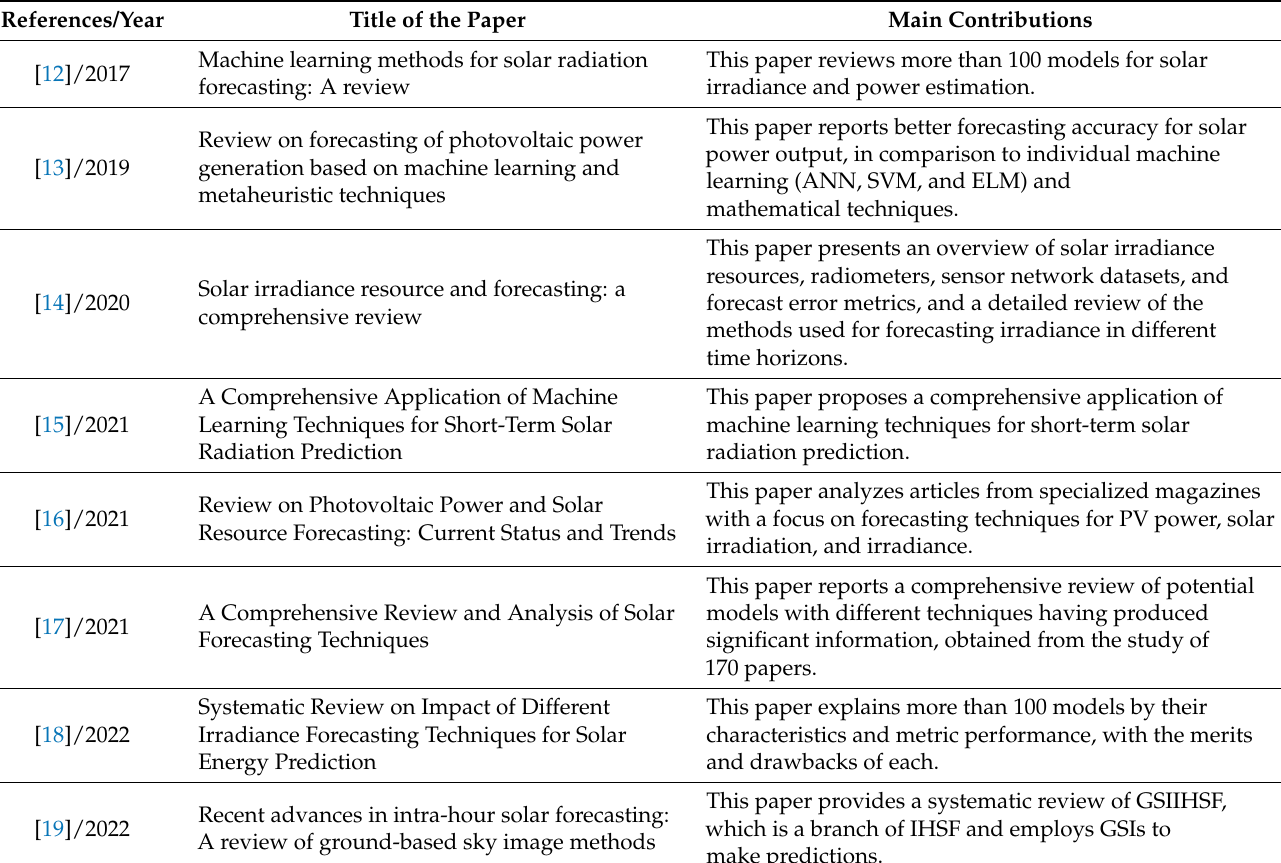
Table 1. Current reviews of solar irradiance and power forecasting